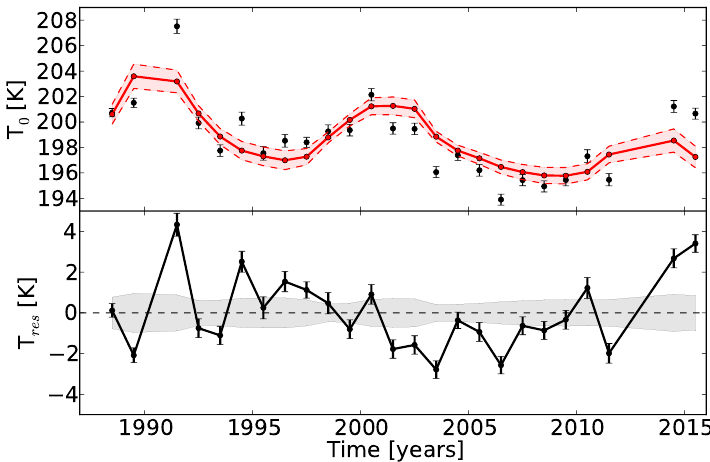
Figure 6. The upper panel of the figure shows the time series of annual average OH ∗ temperatures in black and the fit corresponding to Eq. (3) with the regression coefficients C trend = (0.089 ± 0.055)Kyear − 1 and C solar = (4.2 ± 0.9)K ( 100SFU ) − 1 in red. The black error bars show the uncertainties of the temperatures σ T and the reddish area defined by the dashed red lines shows the 1 σ uncertainty σ fit of the 0 fit. In the lower panel the residual T res of the two is shown. The black error bars show the uncertainties of the temperatures σ T area around the zero line shows the uncertainty of the fit.